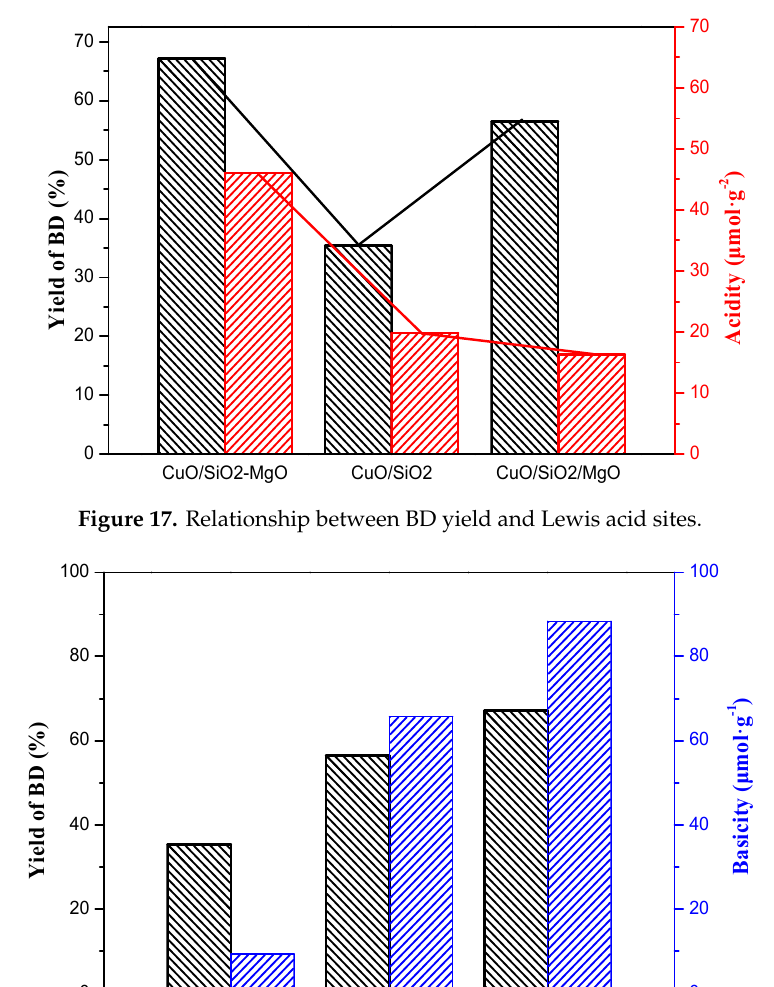
Figure 17. Relationship between BD yield and Lewis acid sites.